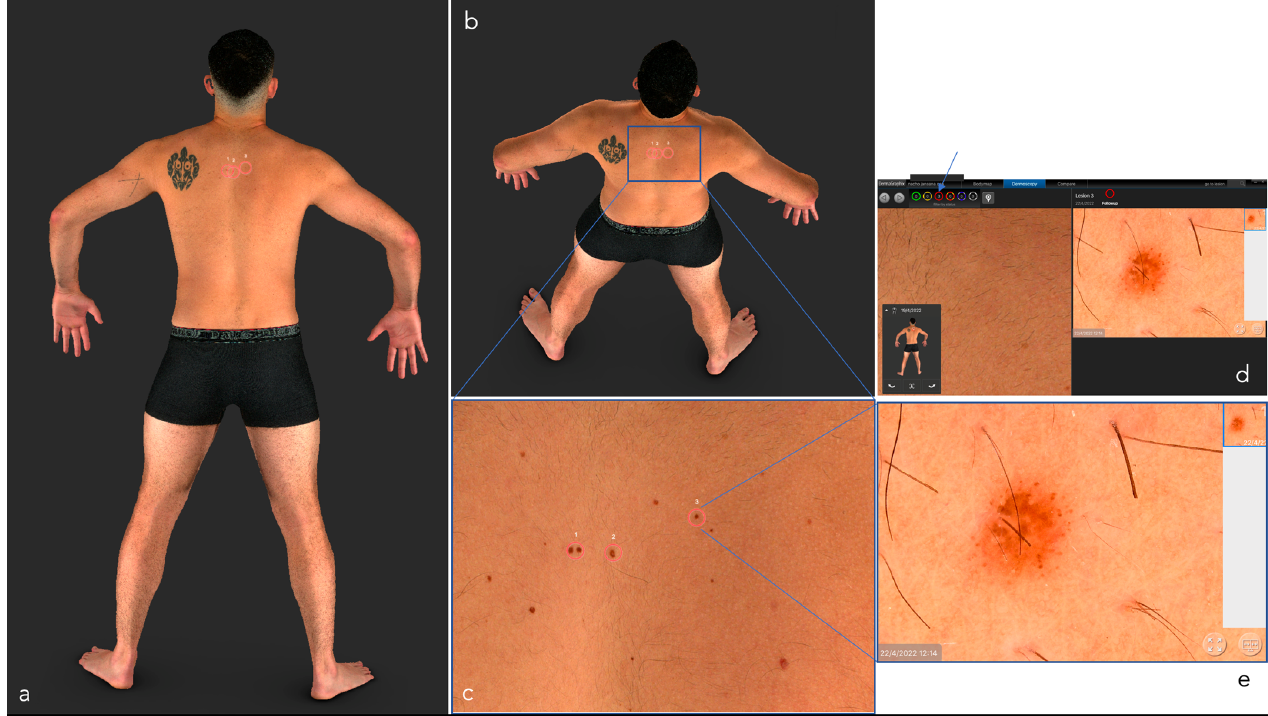
Figure 3. Total body photography. VECTRA WD 360. CANFIELD ® 3-Dimensional.Each selected lesion receives a number. Lesion “3” (blue arrow) is amplified as an example of the magnification: ( a ) 3D total body reconstruction; ( b ) Selected area to be analyzed; ( c ) Melanocytic nevus in follow up; ( d ) Macroscopic view of the selected nevus in the screen. Red circle shows the nevus in follow up; ( e ) Image magnification of the selected nevus. Details in blue squares.